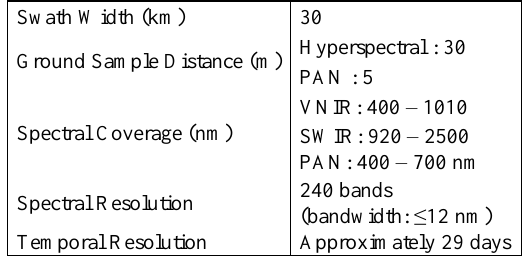
Table 1. Data specifications of the PRISMA satellite images (Url-2).